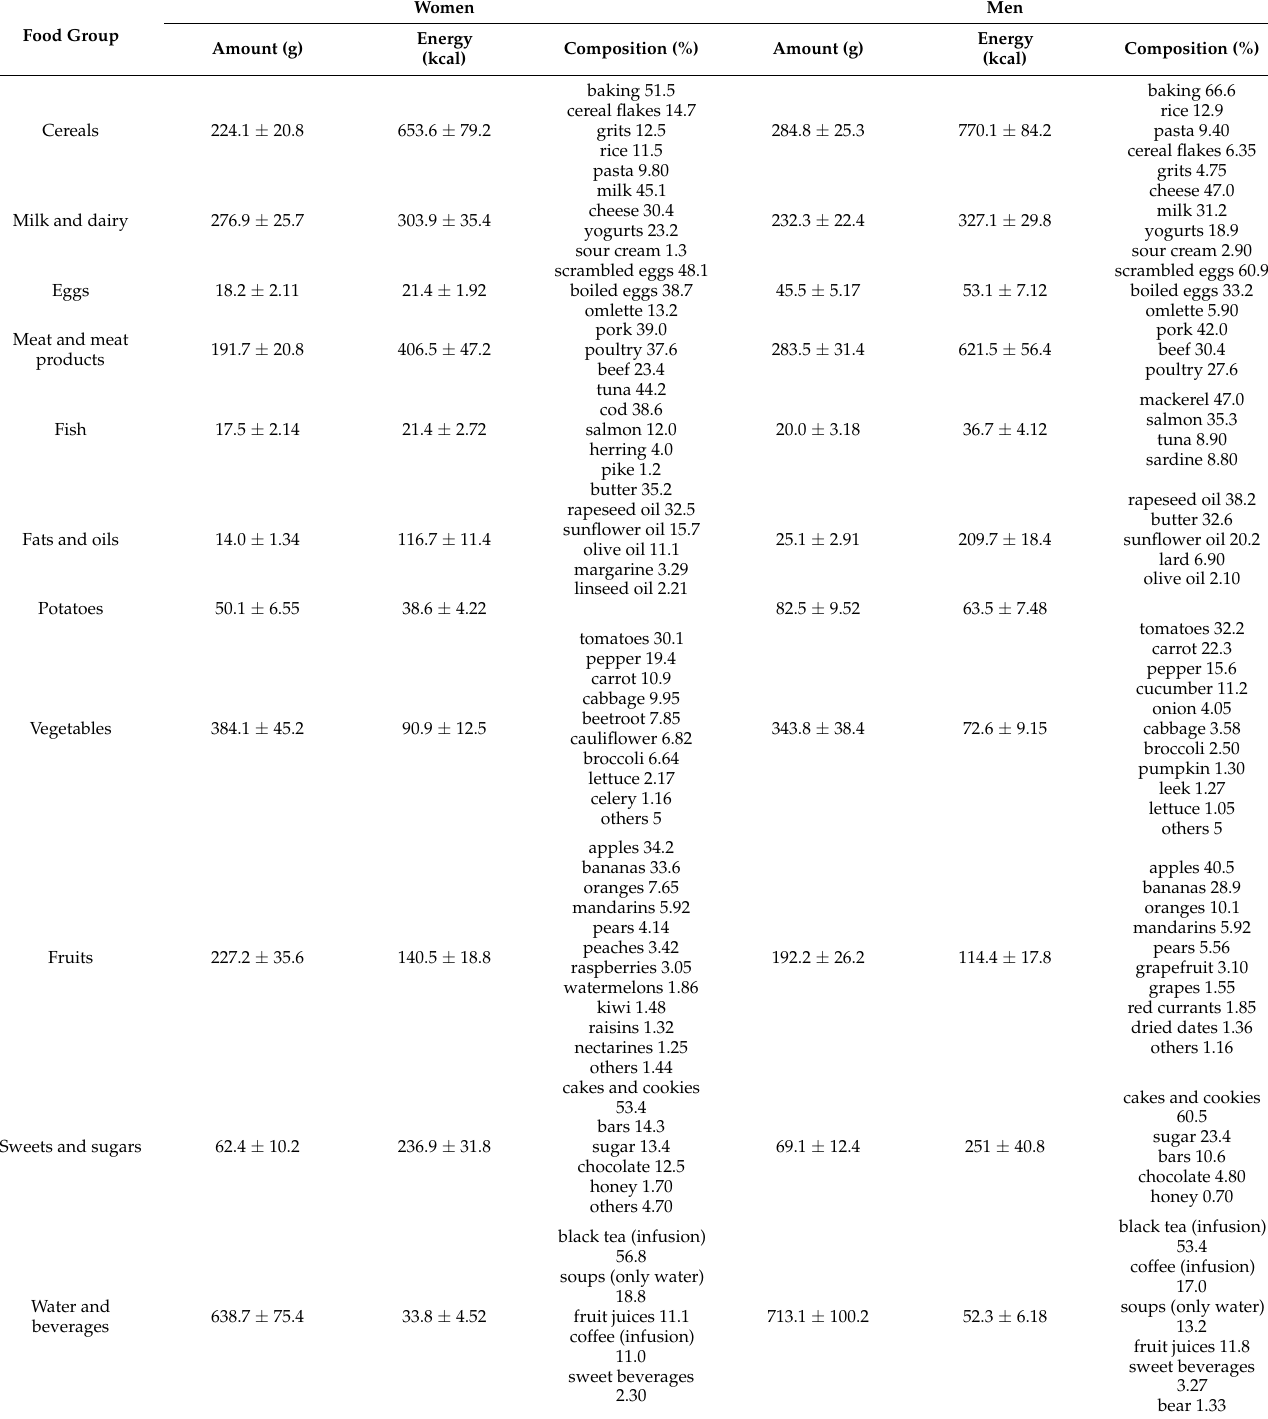
Table 1. Composition of food groups among women and men *